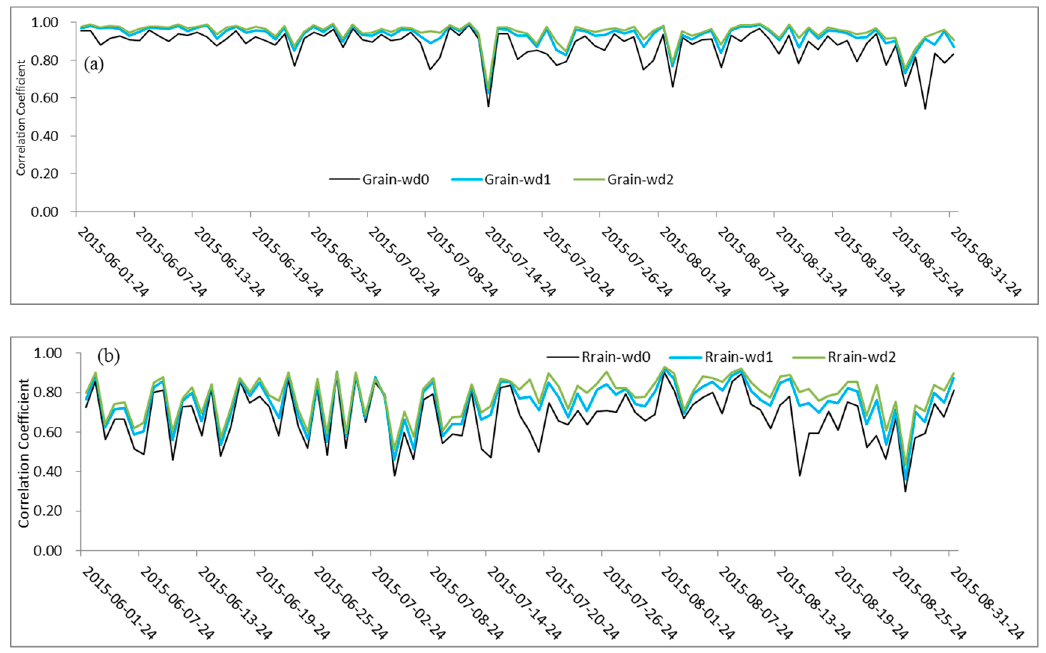
Figure 14. ( a ) Time series of correlation coefficients between the hydrological precipitation observations and gauge precipitation analysis (Grain); ( b ) time series of correlation coefficients between the hydrological precipitation observations and radar QPE (Rrain) and at the three sampling windows, wd0, wd1 and wd2, respectively, from June–August 2015.